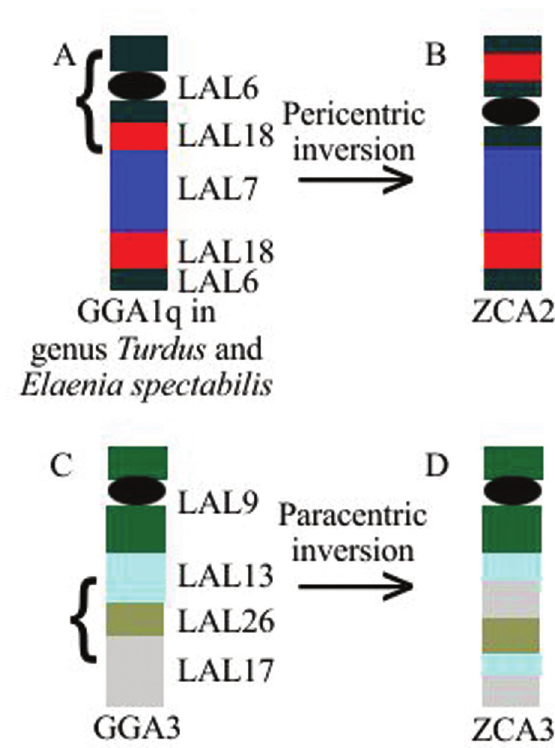
Figure 4 - Inversions on the chromosomes of rufous-collared sparrow demonstrated by the application of probes of L. albicollis , compared to other passerines for chromosome ZCA2 and compared to GGA3 for chro- mosome